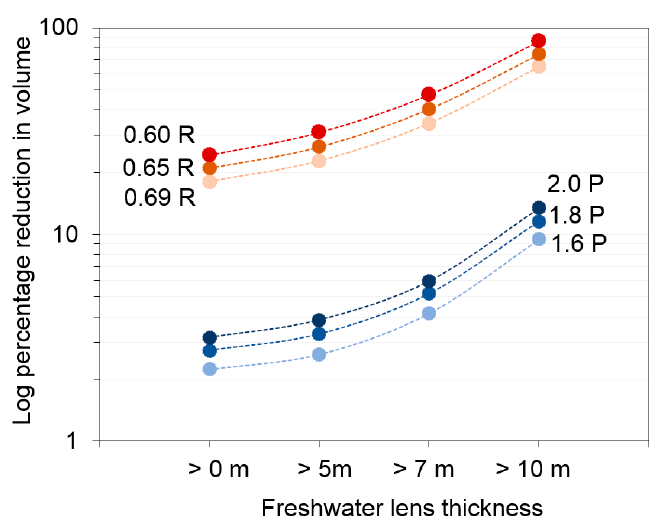
Figure 5. Reduction in volume of the freshwater lens compared to base case under various rates of recharge and pumping compared to base recharge of 570 mm/year (R) and current pumping of 16,710 m 3 /day (P).